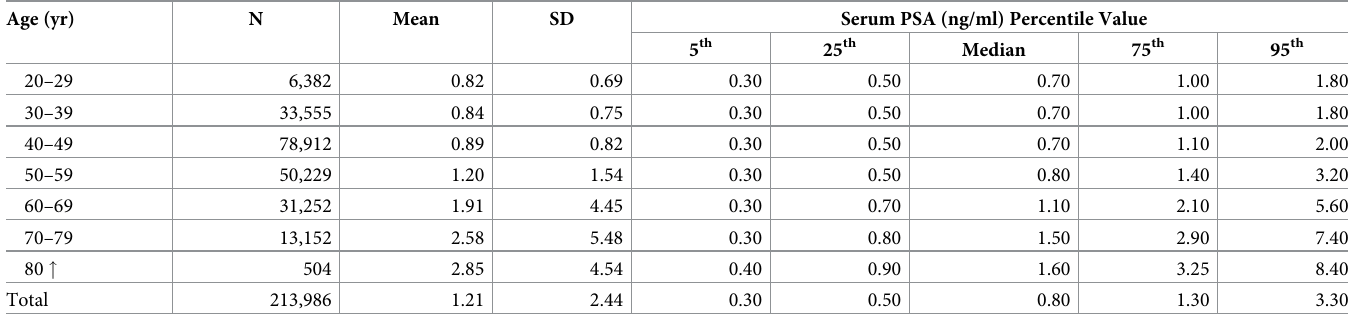
Table 1. Serum PSA according to age in 213,986 Taiwanese men.